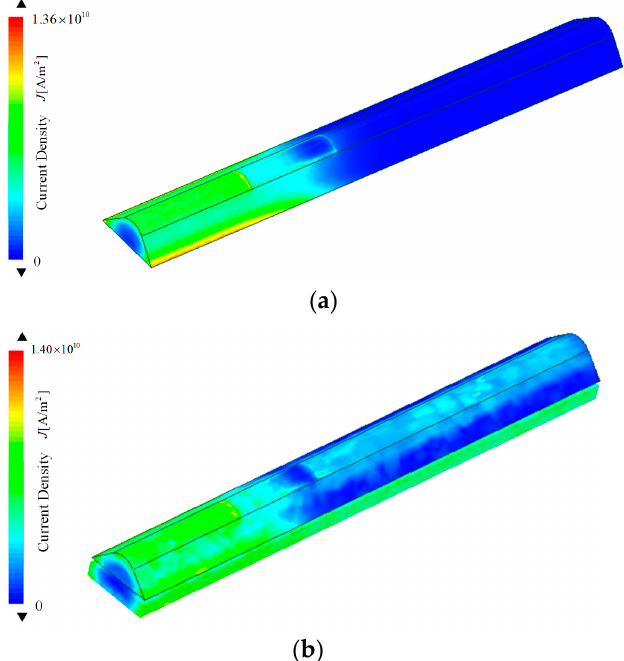
Figure 2. Current density distribution: ( a ) nonenhanced rail; ( b ) enhanced rail.